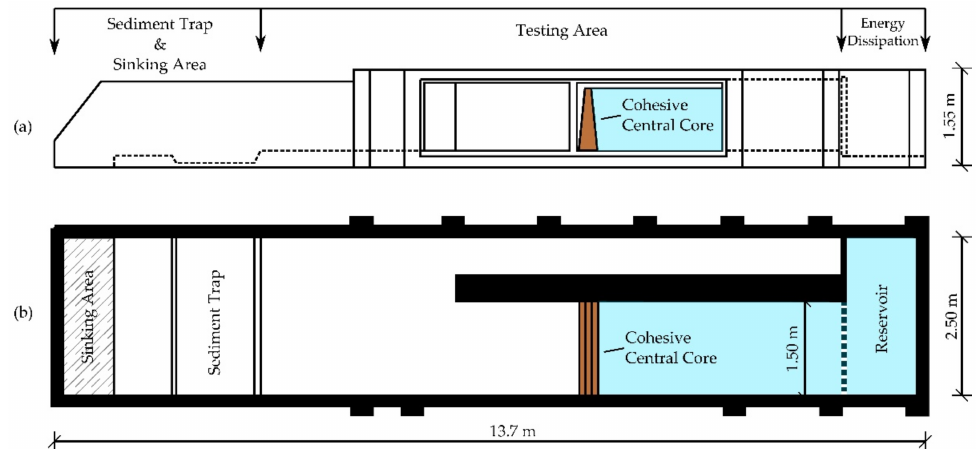
Figure 1. Scheme of the location of a cohesive central core inside the UPM flume: ( a ) Side view of the left wall; ( b ) Top view of the